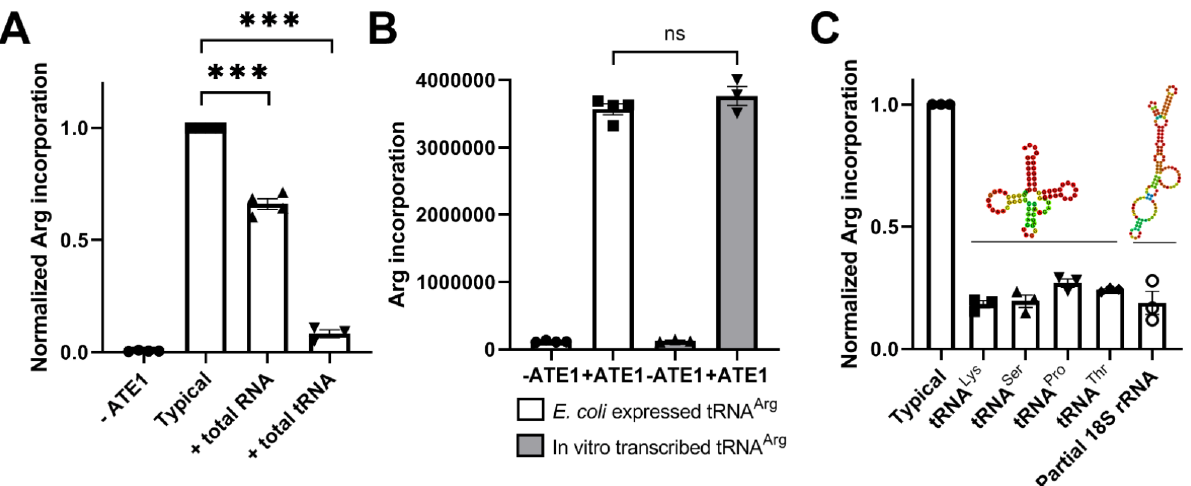
Figure 1. tRNA and 18S rRNA inhibit arginylation in vitro. ( A ) Incorporation of 3 H-Arg into angiotensin II in a typical arginylation reaction (typical), with and without addition of different RNA preparations, as marked on the figure. ( B ) Comparison of native tRNA Arg expressed in E. coli and in vitro transcribed tRNA Arg in the in vitro arginylation reaction. ( C ) Incorporation of 3 H-Arg into angiotensin II in a typical arginylation reaction (typical), with and without addition of different tRNA types, as marked on the figure. Structural models of a typical tRNA (modeled from mouse tRNA Thr ACG-1-1) and the 18S rRNA fragment used in the reaction are shown on top for comparison of the predicted stem-loop structures. Cpm counts in each reaction set were normalized to the typical reaction. Error bars represent SEM, at least n = 3 independent reactions; *** p < 0.001, ns, not significant, Welch’s t